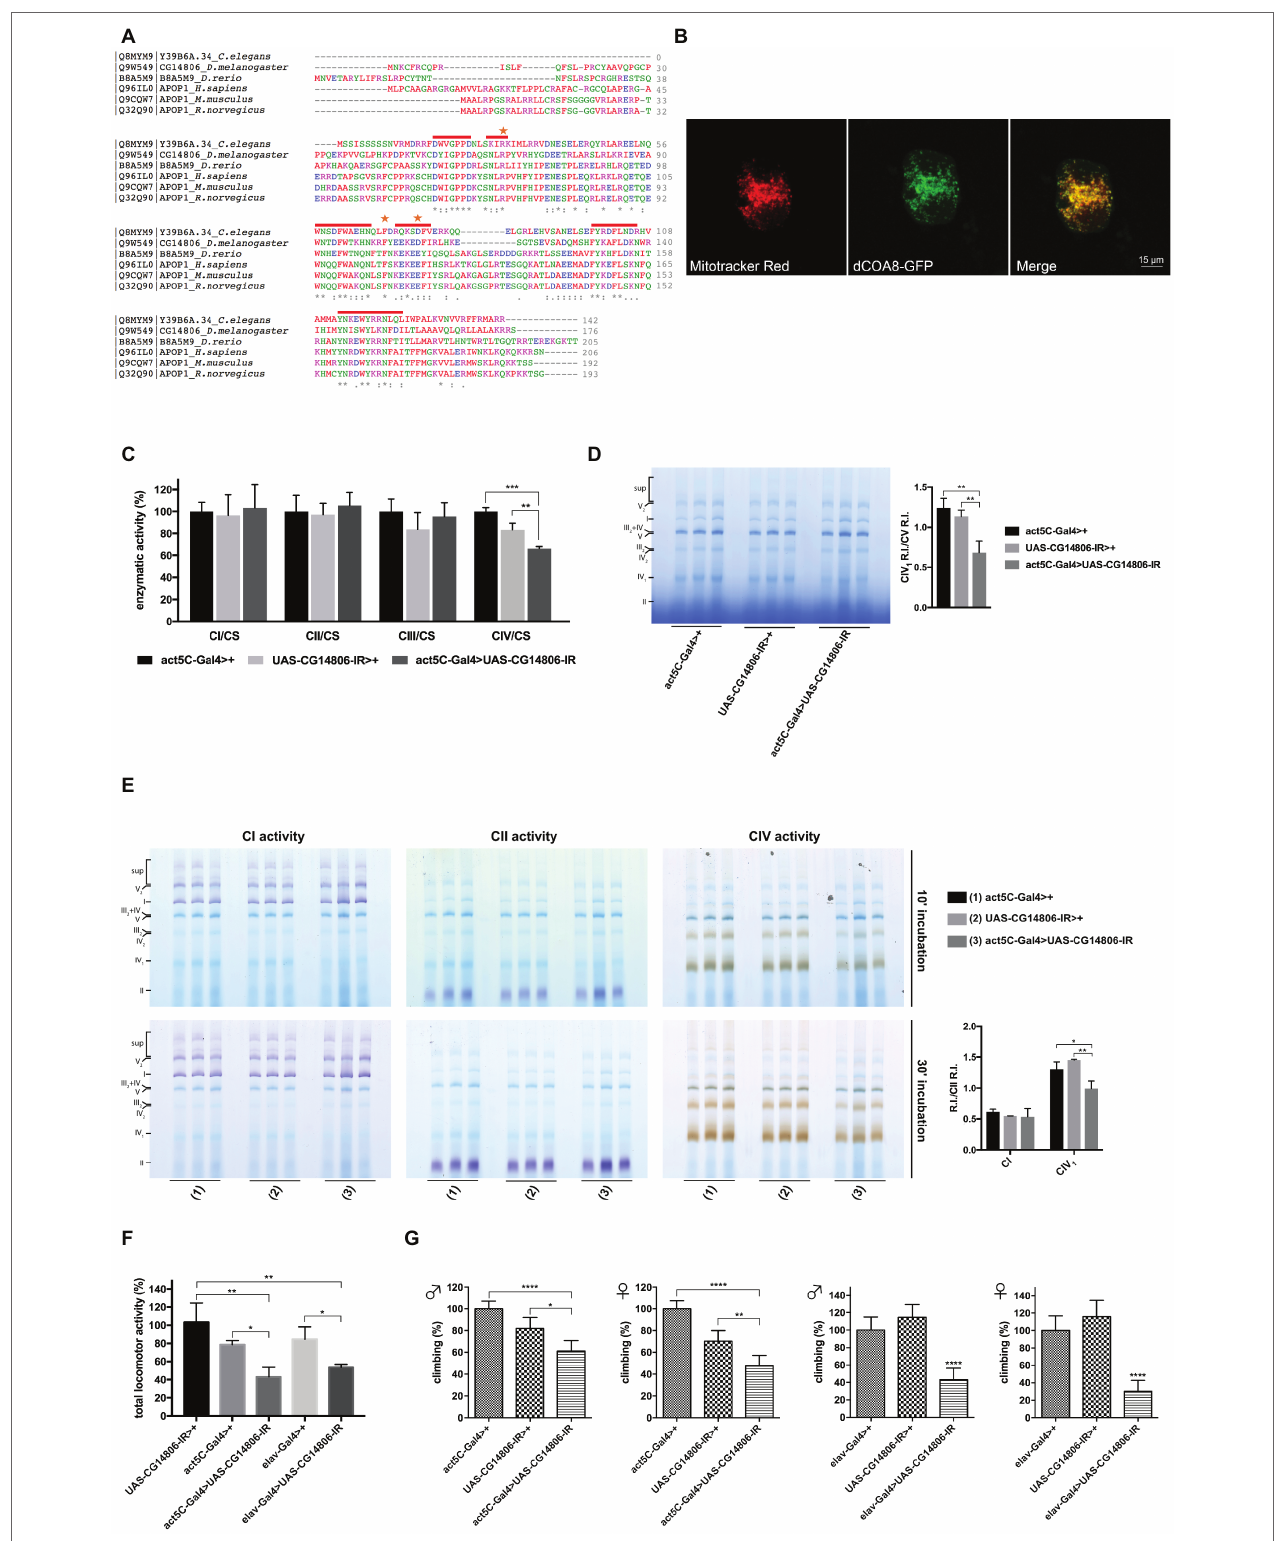
FIGURE 1 | Identification and characterization of the D. melanogaster ortholog of H. sapiens COA8 (APOPT1). (A) Amino acid sequence alignment of C. elegans , D. melanogaster , D. rerio , H. sapiens , M. musculus , and R. norvegicus COA8 orthologs. The shown alignment was performed using the Multiple Sequence